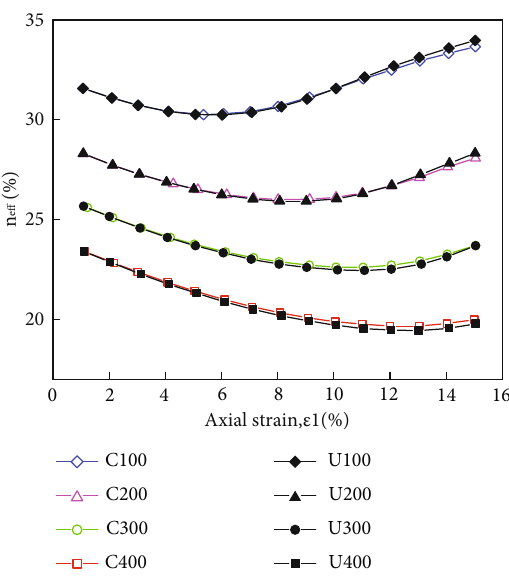
Figure 8: Evolution curve of e ff ective porosity of samples under di ff erent con fi ning